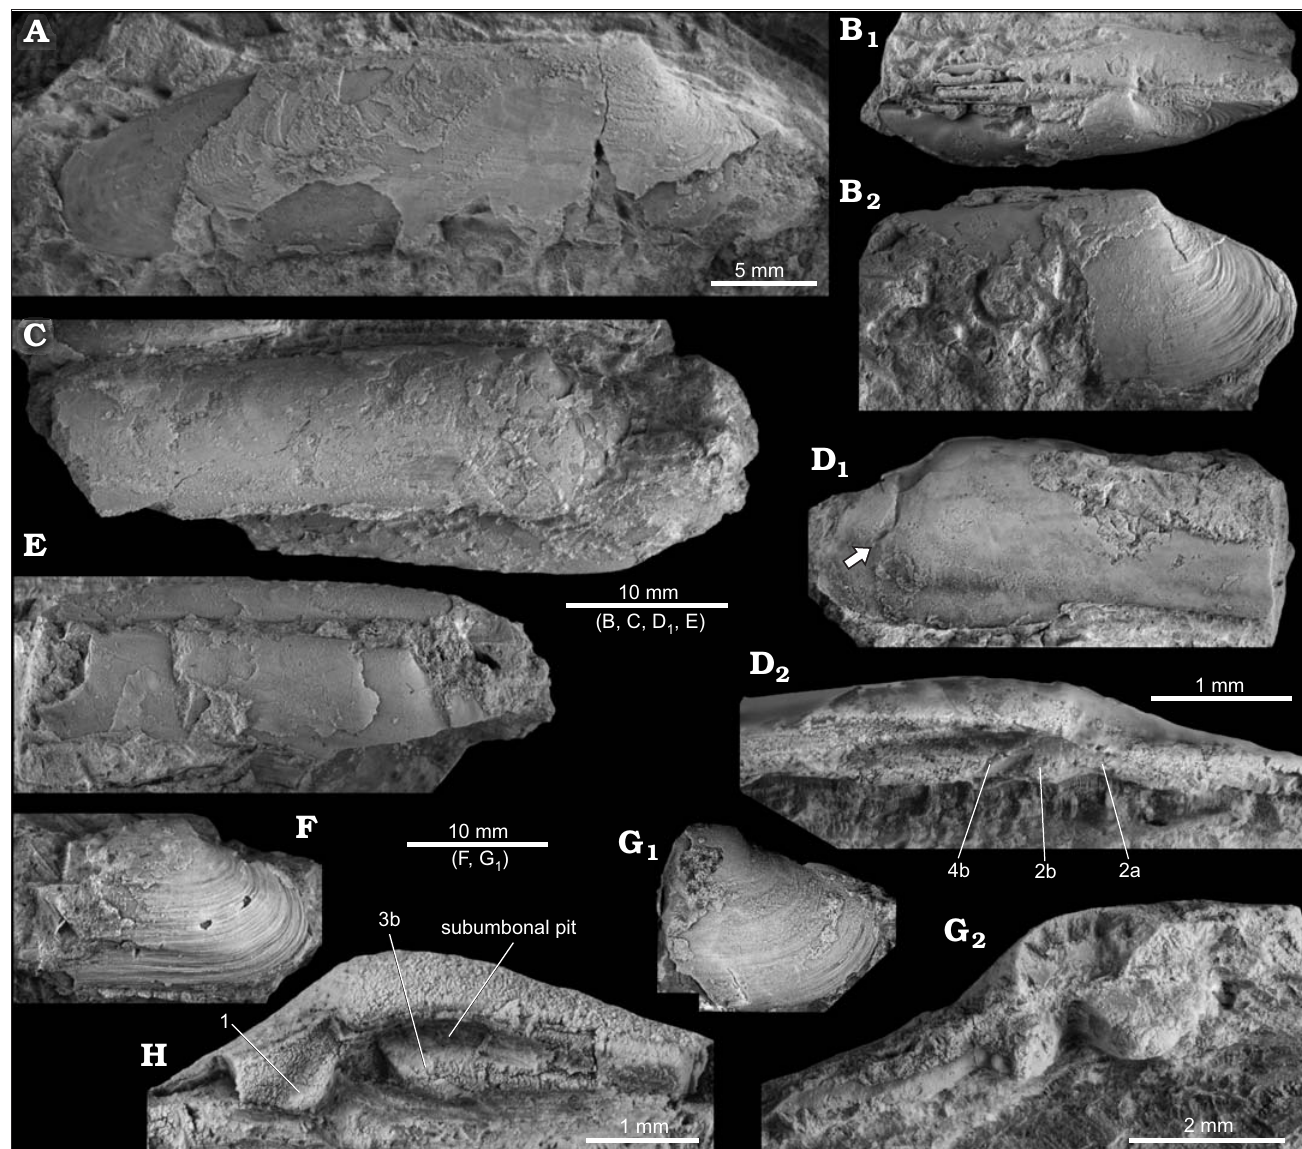
Fig. 7. The vesicomyid Pleurophopsis talarensis sp. nov., from early Oligocene seep deposits at Cerro La Salina (block 6, A, D, F–H; block 7, E; block 9, B, C), Talara Basin, northern Peru. A . Holotype (NRM Mo187019), right valve showing shell outline. B . Paratype (NRM Mo187022), posteriorly damaged, articulated specimen; view on dorsal side (B 1 ) and on right valve (B 2 ). C . Paratype (NRM Mo187020), right valve with posterior tip missing. D . Paratype (NRM Mo187023), internal mold of left valve showing anterior adductor muscle scar and pallial line (D 1 ), arrow indicates onset of pallial; close-up on hinge area (D 2 . E . Paratype (NRM Mo187021), semi-articulated specimen, view on incomplete right valve). F . Paratype (NRM Mo187024), anterior part of fight valve. G . Paratype (NRM Mo187026), anterior part of right valve (G 1 ), view on hinge area (G 2 ). H . Paratype (NRM Mo187025), hinge area of right